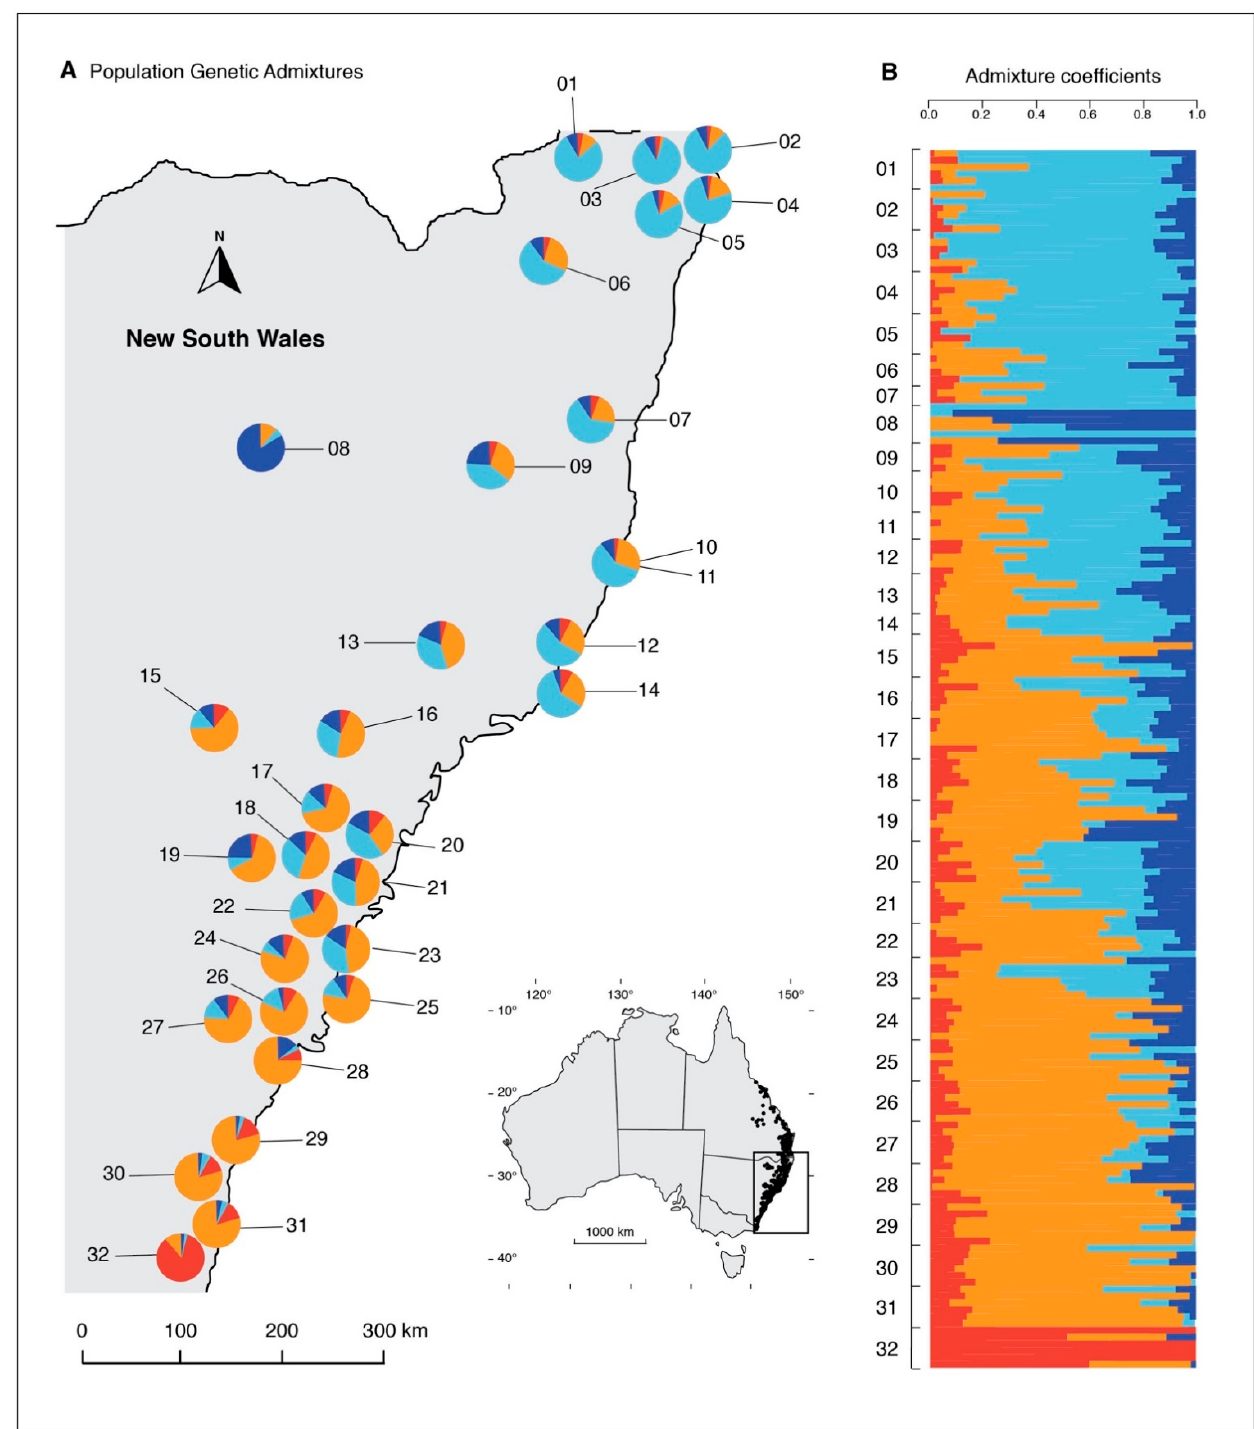
Figure 3. Sampling sites are numbered from most northern (01—Brunby Plains) to most southern (32—Brogo); see Table 1 for details. ( A ) Geographic location and population mean LEA genetic admixture (K = 4); ( B ) LEA genetic admixture (K = 4) for each individual.